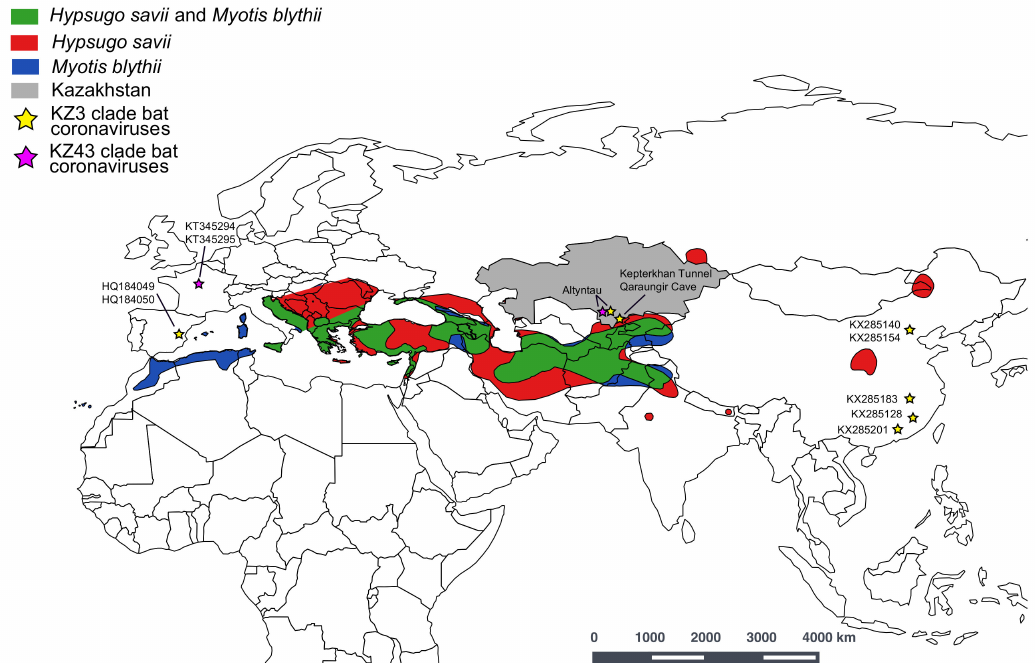
Figure 3. A map of the geographic distribution of Myotis blytii and Hypsugo savii species and where their ranges overlap (created in QGIS). The locations of the KZ3 bat coronavirus monophyletic clade (bootstrap (BS) = 76%) are presented on the map (yellow star), including Kazakhstan bat coronaviruses (KZ-3a and KZ-3b: MK603150–MK603157 and MK603159–MK603161), bat coronaviruses from China (KX285128, KX285140, KX285154, KX285183, KX285201), and bat coronaviruses from Spain (HQ184049, HQ184050). The locations of the KZ43 monophyletic clade (BS = 91%) are also listed on the map (purple star), including the Kazakhstan bat coronavirus (KZ43: MK603158) and bat coronaviruses from France